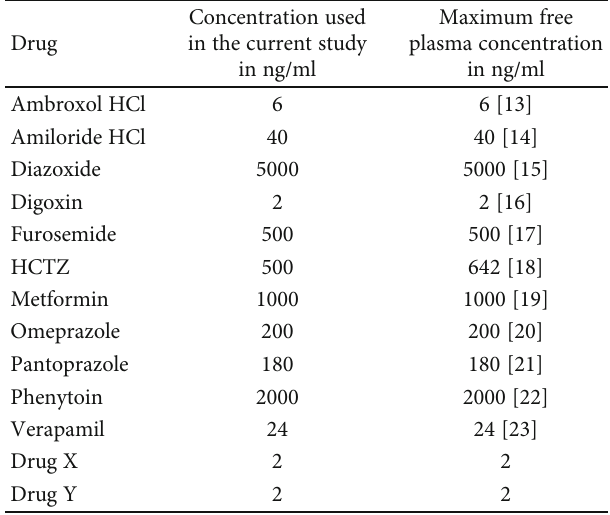
Table 1: Concentrations of drugs tested in the current study and their maximum free plasma concentrations in humans when taken at therapeutic doses.